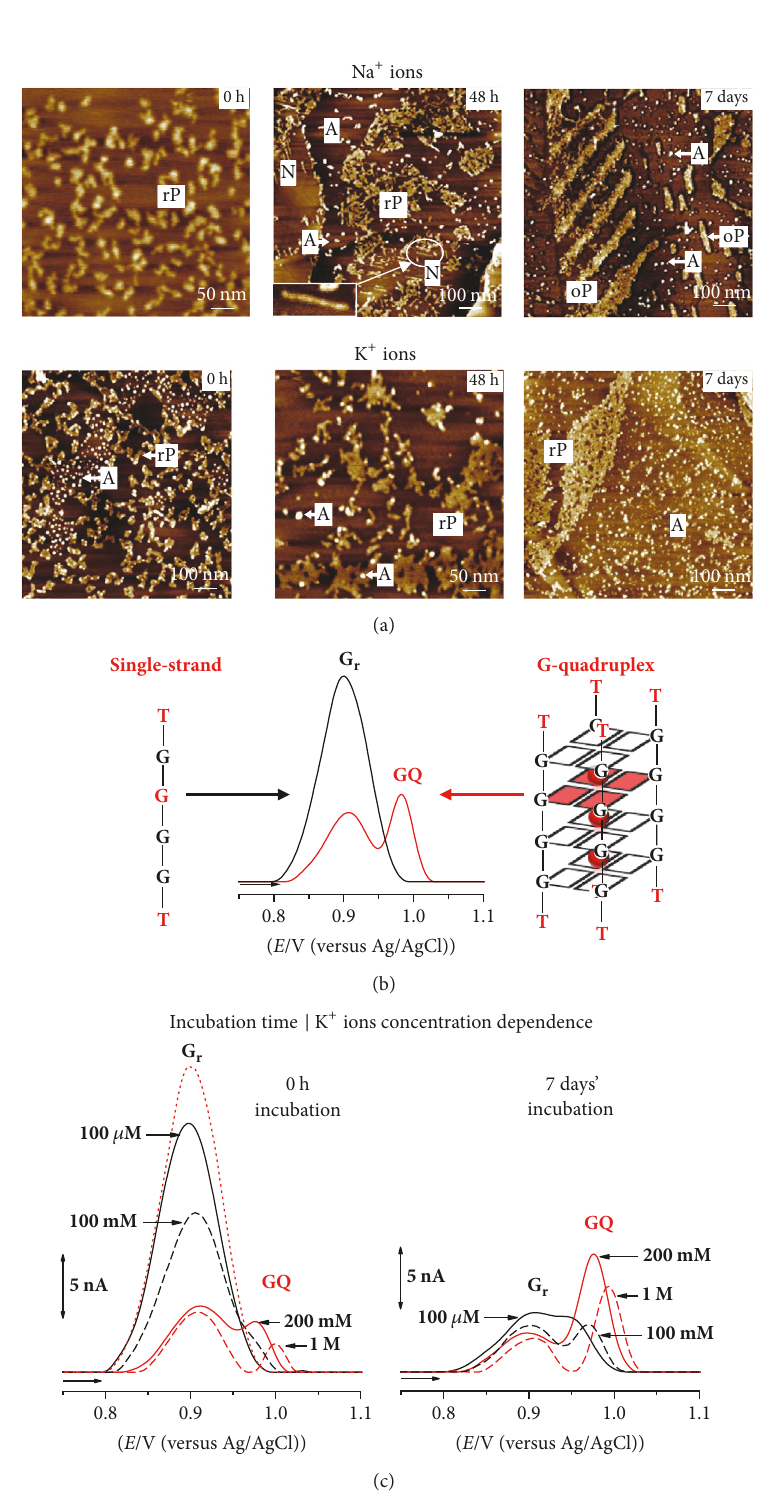
Figure 3: (a) AFM image of 0.3 𝜇 M d(TG 4 T) in pH 7.0, in the presence of Na + and K + ions, at different incubation times; (b) representation of the d(TG 4 T) single-strand and GQ electrochemical detection; (c) DP voltammograms baseline corrected in 3.0 𝜇 M d(TG 4 T) in pH 7.0: incubation time and K + ions concentration dependence. [Adapted from [51] with